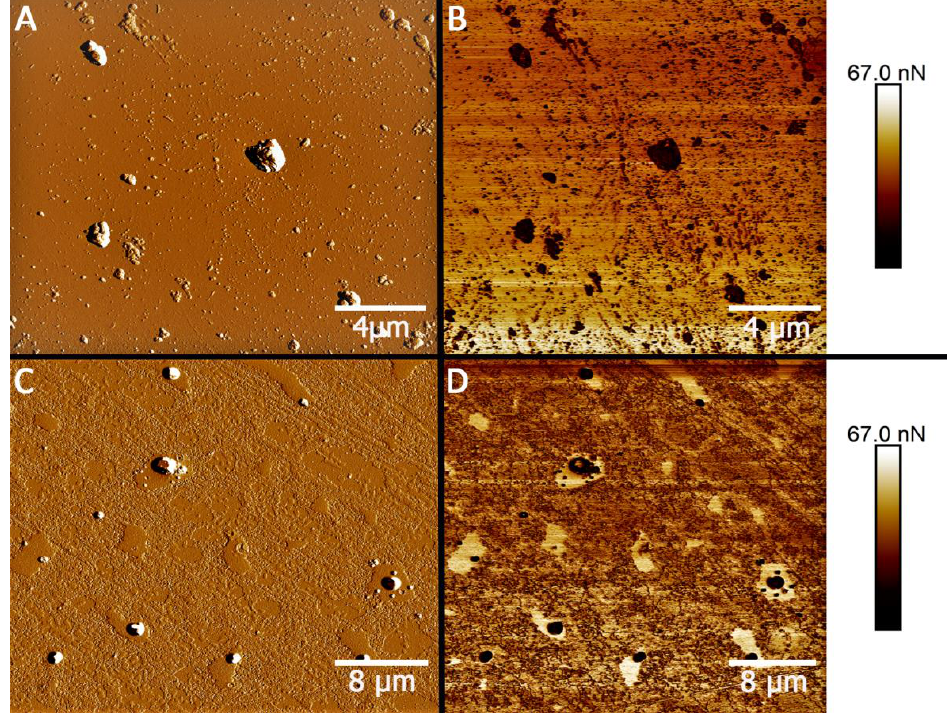
Figure 2. AFM images of pristine ( A , B ) and hydrophobic ( C , D ) montmorillonite obtained in the Peak Force Error ( A , C ) and Adhesion ( B , D ) channels.